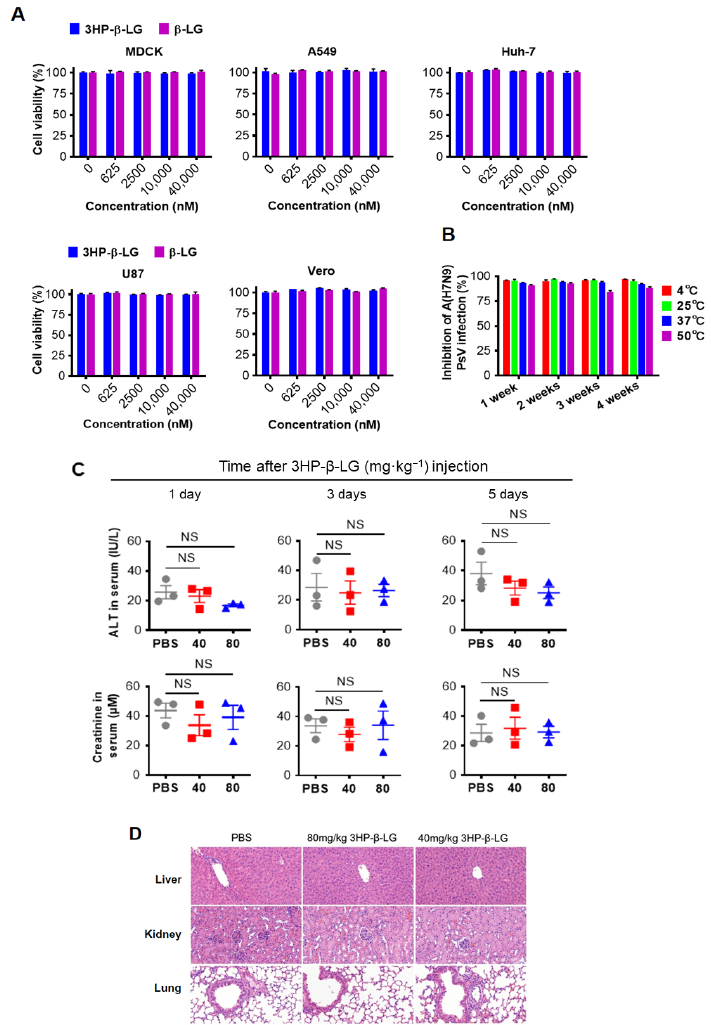
Figure 3. Safety in vitro and in vivo and stability of 3HP- β -LG. ( A ) Cytotoxicity of 3HP- β -LG and β -LG on MDCK, A549, Huh-7, U87, and Vero cells was detected by CCK-8 kit. ( B ) Stability of 3HP- β -LG stored at 4 °C, 25 °C, 37 °C, and 50 °C for 1, 2, 3, and 4 weeks, respectively. The percentage of inhibition of 3HP- β -LG against influenza A(H7N9) PsV was detected by luciferase assay. ( C ) The activity of ALT (IU/L) and serum creatinine in sera collected from mice at days 1, 3, and 5, respectively, after they were administered intranasally with 3HP- β -LG at 80 and 40 mg/kg, respectively, or PBS (as a control). Samples were tested in triplicate and data are presented in mean ± SD. Each experiment was repeated at least twice. NS denotes no significance. ( D ) Histopathological changes in the liver, kidney, and lungs in the mice that were administered intranasally with 3HP- β -LG at 80 and 40 mg/kg, respectively, or PBS (as control), at day 30 after the first administration of 3HP- β -LG.